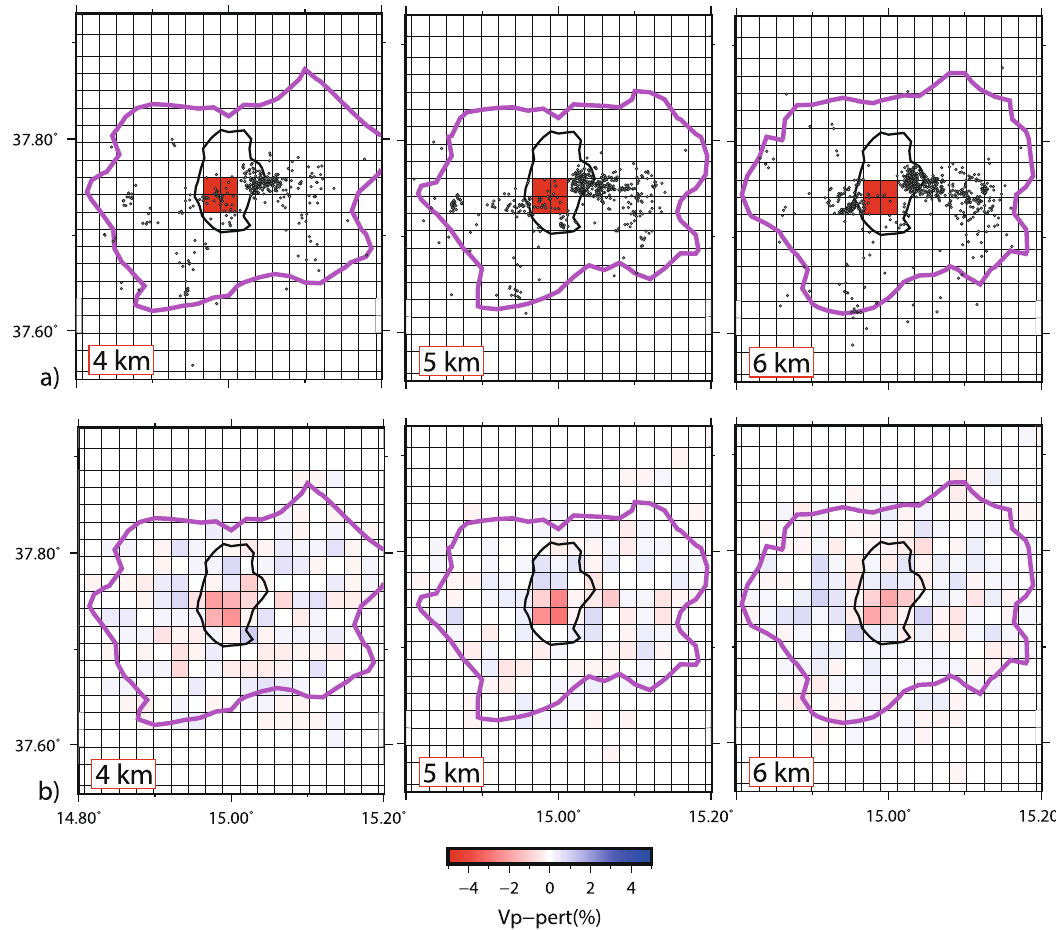
Fig. 6 Reliability of the transient Vp change at Mt. Etna. Synthetic test: an arti fi cial low-velocity anomaly ( a ) is introduced in the 2019 – 2021 sub-period and the inversion procedure is repeated as in the real inversion, with similar hypocentral and velocity parameters and damping. Note the good recovery ( b ) of the low-velocity anomaly, although with a slightly minor